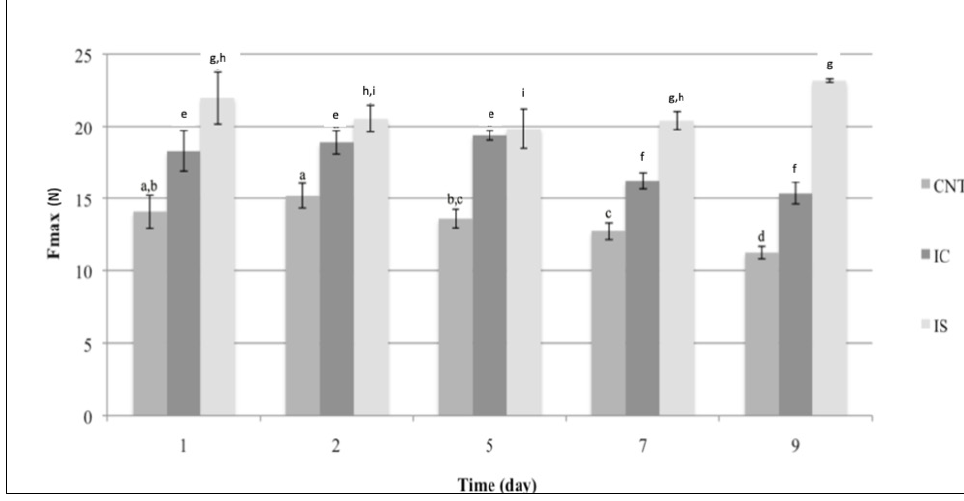
Figure 1. F max (N) of fiordilatte cheese with inulin from chicory (IC), from cardoon (IS) and without inulin (CNT), during storage time. a – i Different letters indicate significant differences ( p < 0.05) within each sample during storage time. Values are means of twenty replications ± standard deviation.